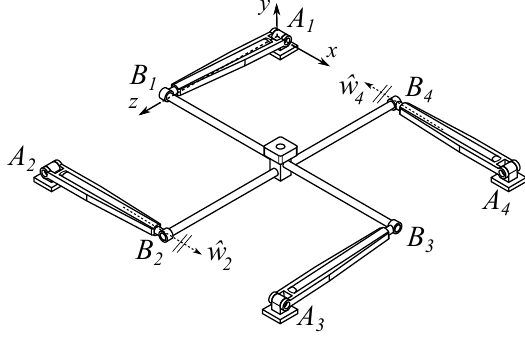
Figure 7. A direct singularity: ˆ w 2 and ˆ w 4 are parallel.